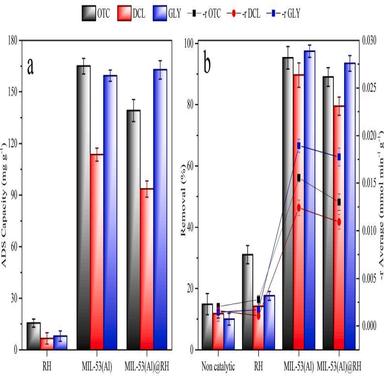
Comparison of a) ADS capacity, b) % removal, and average degradation rate in AOP for the three materials tested (RH, MIL-53(Al), and MIL-53(Al)@RH.